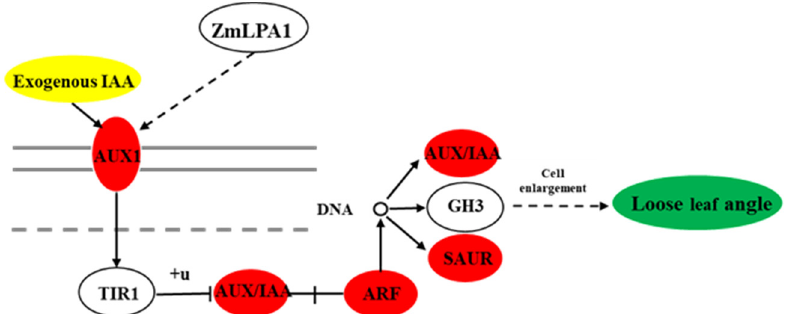
Figure 10. ZmLPA1 gene regulates maize leaf angle. ZmLPA1 acts as a central gene that directly regulates the auxin signaling pathway, thereby regulating the size of leaf angle. The red circle indicates that the expression of auxin-related genes in mutant lpa1 is higher than that in wild-type B73 under exogenous IAA treatment.